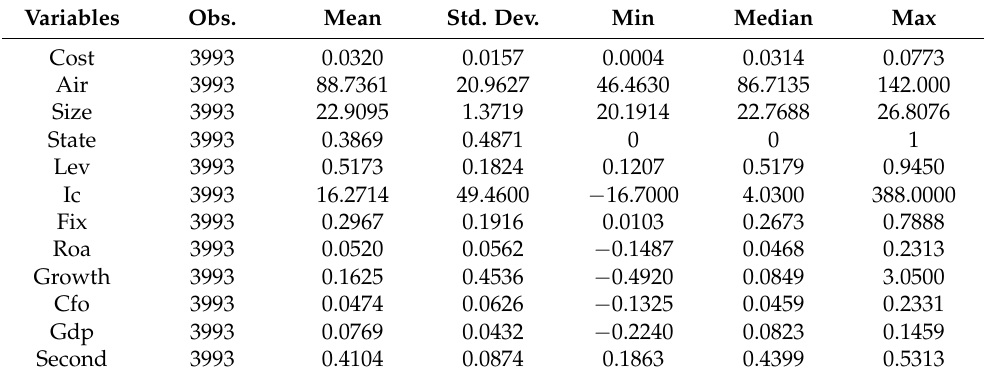
Table 4. Variable descriptive statistics.